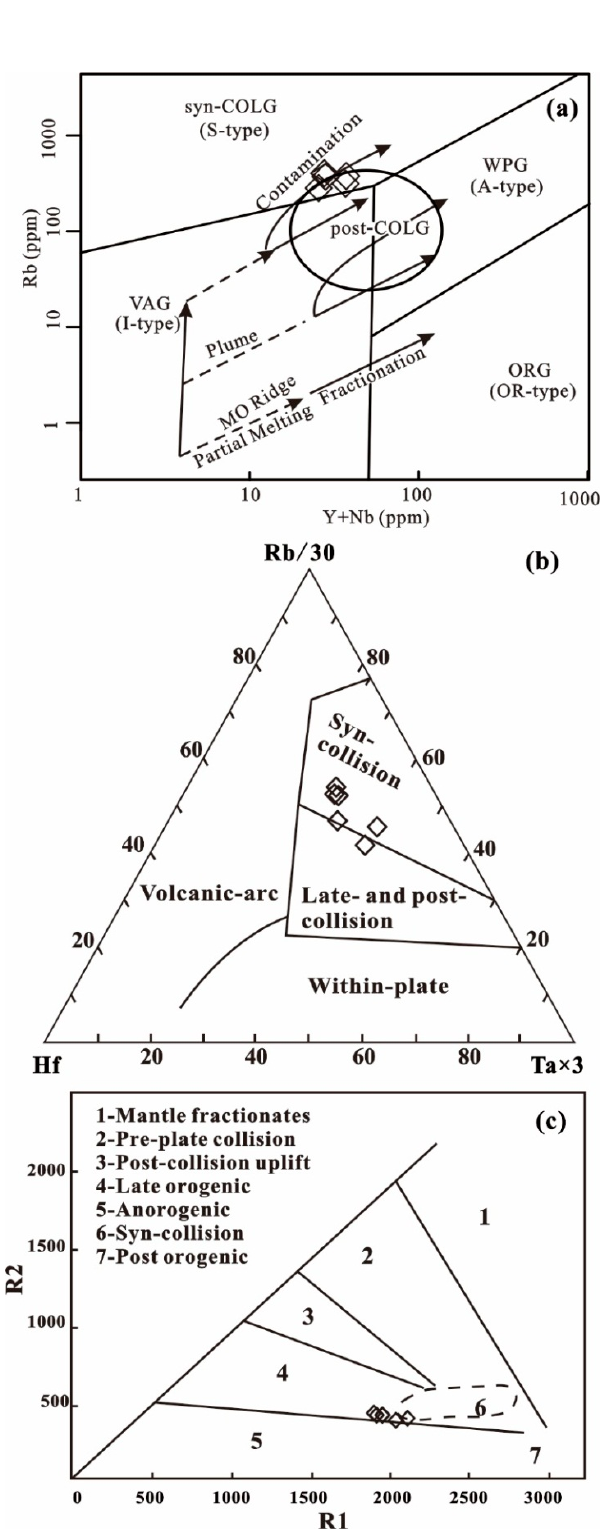
Figure 11. Tectonic discrimination diagrams for granitoid rocks with MG samples plotted from the Wulandele Mo deposit ( a after [30,31]; b after [32]; c after [33]); VAG, Volcanic arc granites; Syn-COLG, Syn-collisional granites; WPG, Within-plate granites; ORG, Ocean ridge granites; post-COLG, post-collisional granites.